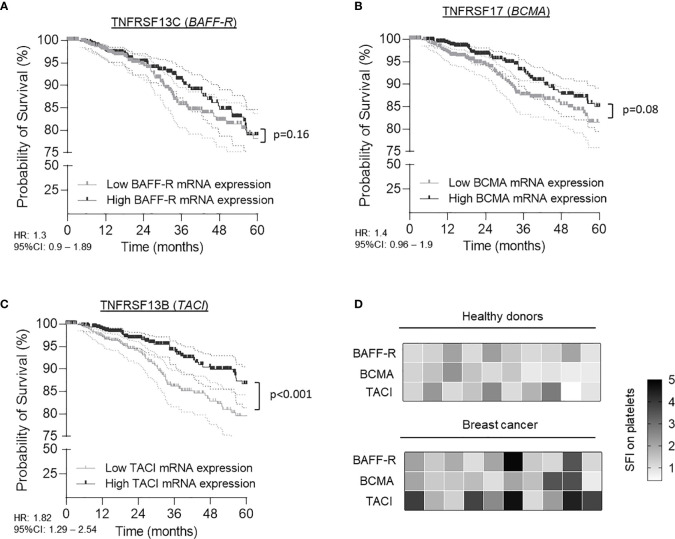
Expression of BAFF-R (TNFRSF13C), BCMA (TNFRSF17) and TACI (TNFRSF13B) in breast cancer patients and association with survival. (A–C) Association of BAFF-R
(A), BCMA
(B) and TACI
(C) mRNA expression with patient survival was calculated using the TCGA Research Network database. Gene expression was analyzed from tumor tissue of 1,006 patients. Low and high expression was defined according to the respective median mRNA levels of the entire cohort. (D) Specific fluorescence intensity (SFI, defined as fold change ‘specific signal obtained by specific antibody’/’signal obtained by respective control’) of BAFF-R, BCMA and TACI surface expression of platelets from 10 HD and 10 breast cancer patients were determined by flow cytometry.